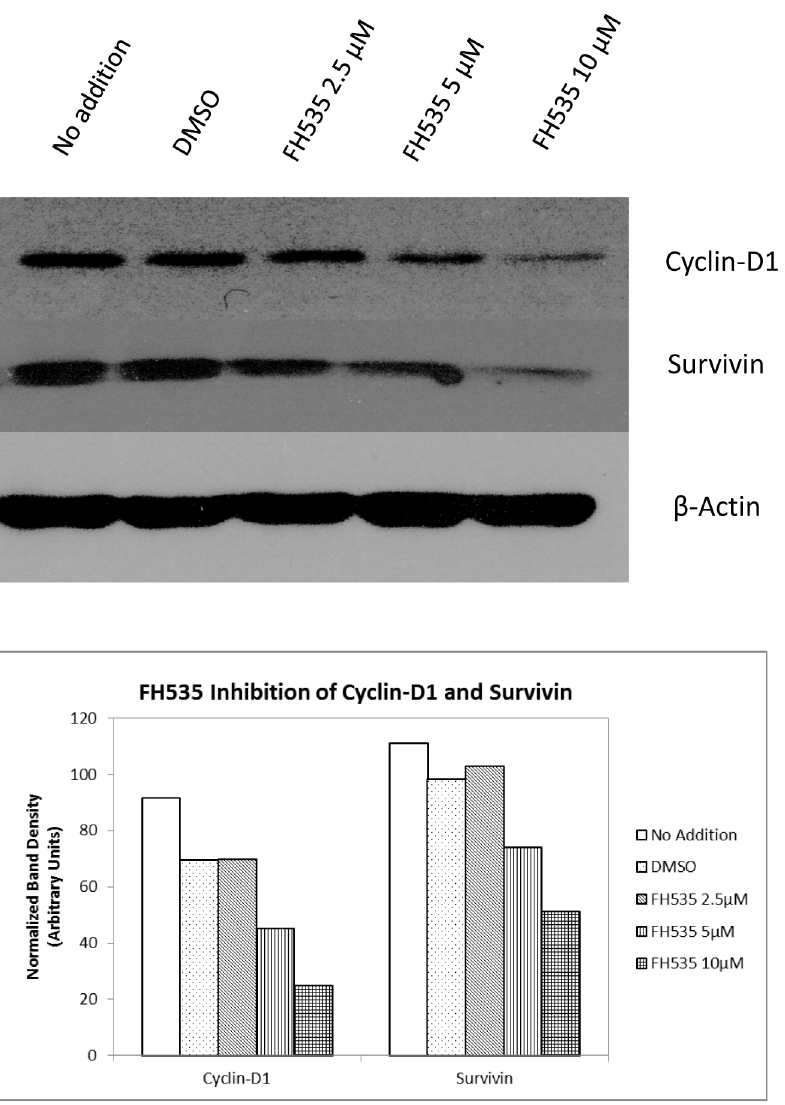
Figure 6. FH535 reduces cyclin D1 and Survivin protein levels in Huh7 cells. Huh7 cells were treated with DMSO alone or increasing amounts of FH535 for 38 hours prior to harvesting. Proteins were prepared, resolved by SDS-PAGE, and transferred for Western analysis with antibodies against Cyclin D1, Survivin, and b -actin. The top of shows the western blot image; the bottom graph shows densitometric analysis of the western data. This densitometric analysis indicated that FH535 at 5 and 10 m M inhibited Cyclin D1 protein levels 28% and 64% respectively; FH535 at 5 and 10 m M inhibited Survivin protein levels 24% and 48% respectively. The experiment was done twice with similar results.